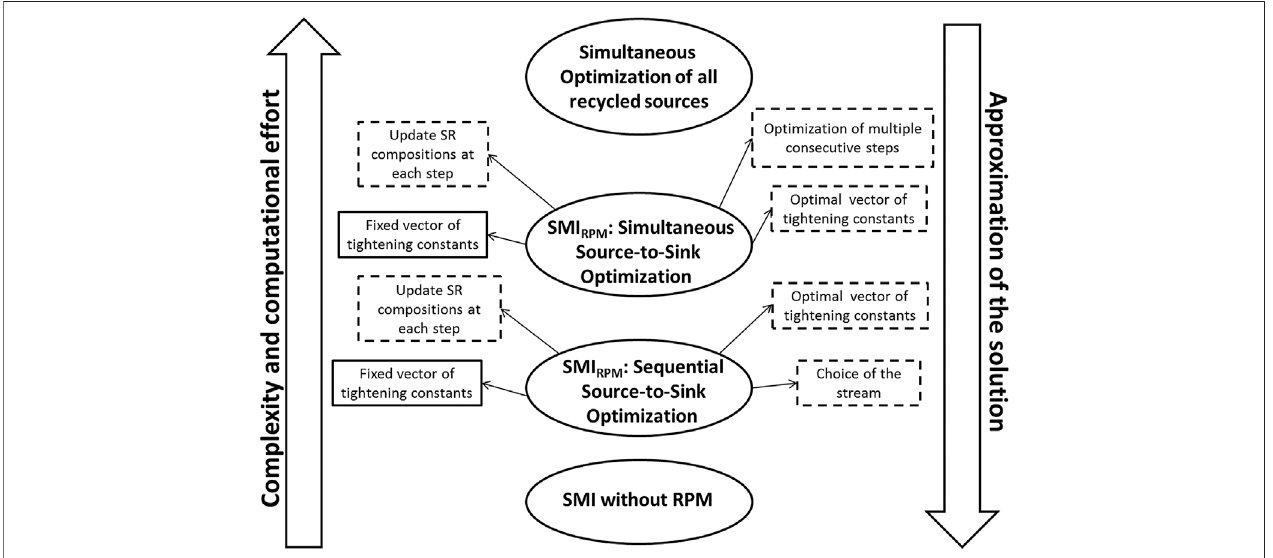
FIGURE 9 | Summary of the algorithms used in this work to realize direct recycling networks with and without rigorous process modelling. Possibilities of further improvement of the approaches presented herein are provided in boxes with dashed contour. The applied methodologies and the potential further improvements are compared according to their level of approximation of the global optimum and the required computational